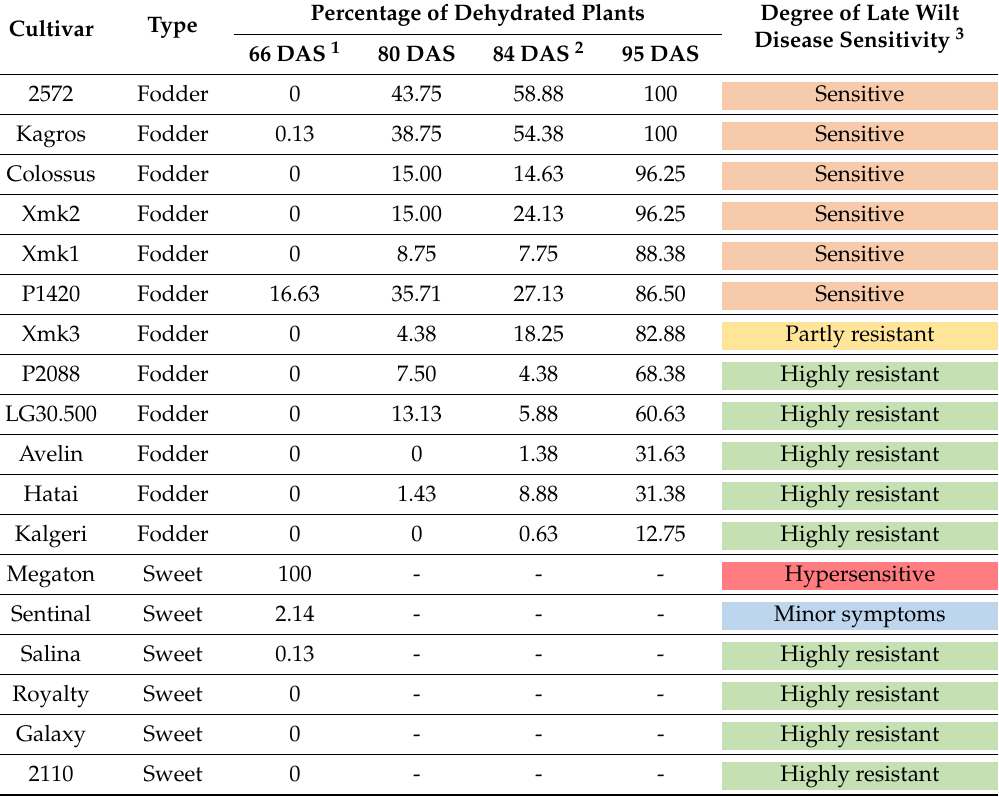
Table 3. The 2017 maize cultivars field examined for late wilt disease sensitivity / resistance. 1.